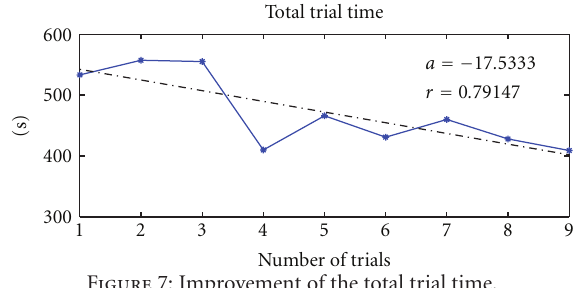
Figure 7: Improvement of the total trial time.